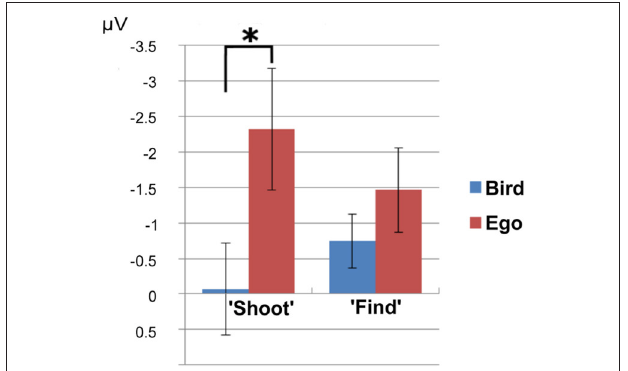
FIGURE 4 | N1 effect. N1 amplitudes showed significantly larger amplitudes in the “Ego” compared to the “Bird”-view condition only for the “shoot”- task, but not for the “find”-task. The asterisk indicates significance at a p -value of 0.05.